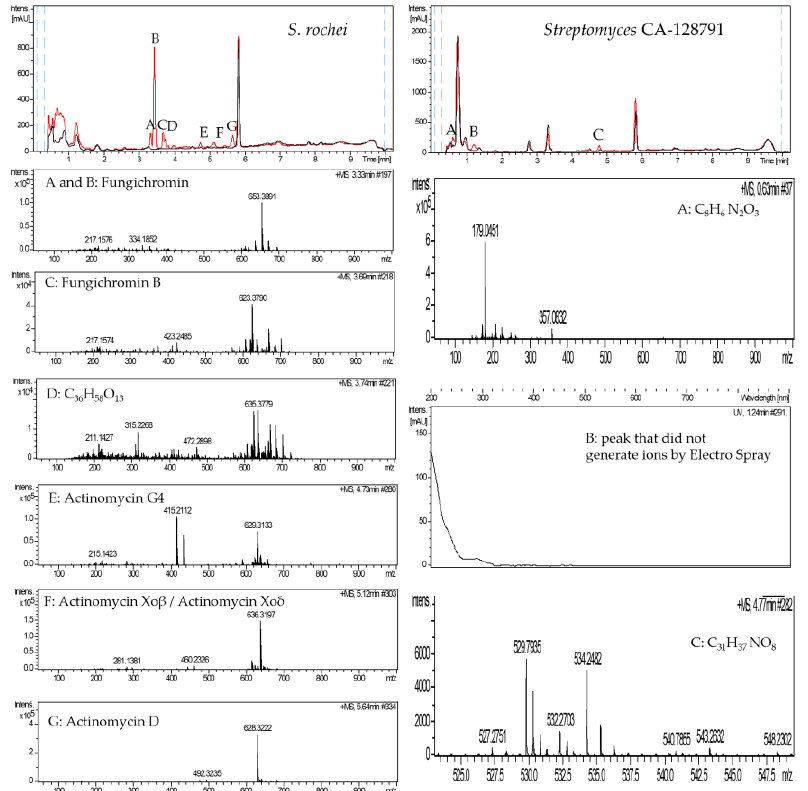
Figure 5. Analysis of the metabolites produced by S. rochei ( left ) and by Streptomyces CA-128791 ( right ) grown in YEPD with water (black) or with SAP (red) detected by UV/Vis absorbance (200–900 nm). Mass spectra of compounds in the differential peaks.